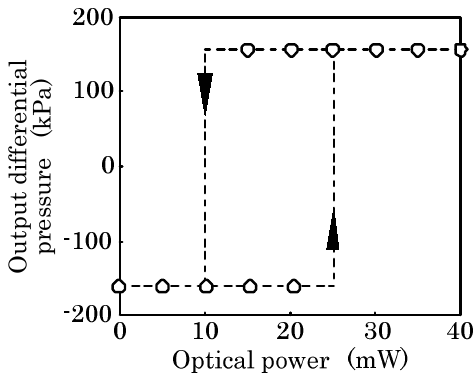
Relation between optical power and output pressure of opto-pneumatic on/off